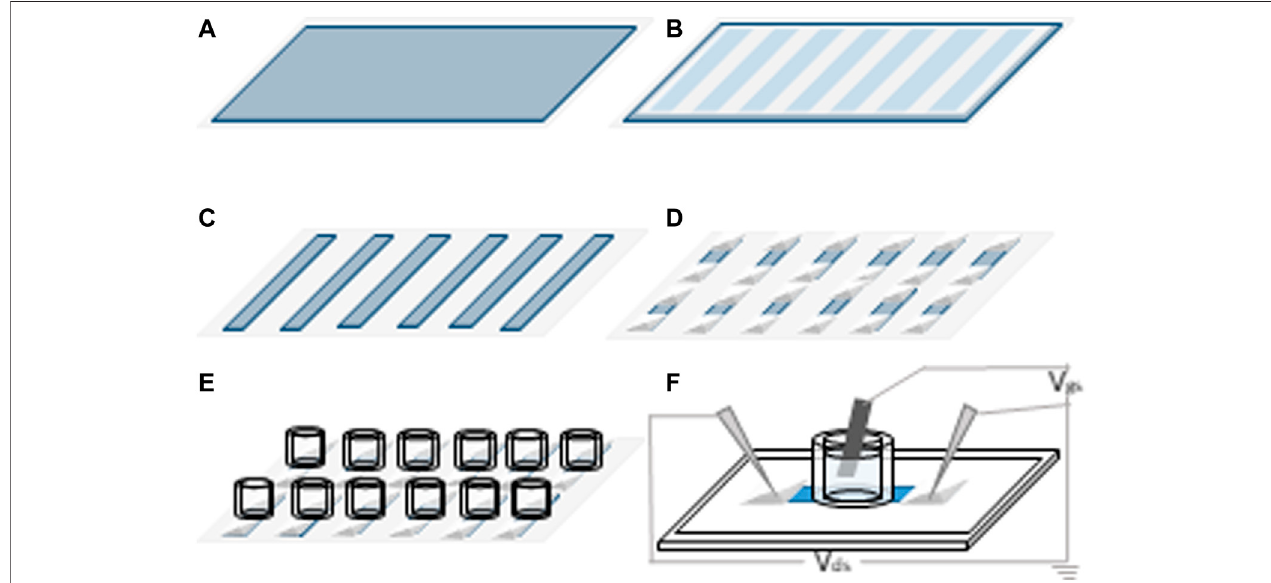
FIGURE1| SchematicrepresentationofthefabricationprocessofOECTs. (A) PEDOT:Toseitherelectrospunorspincoated; (B) PETstencilmaskisusedtocover thesamplesandprotectunexposedareas; (C) plasmaetchingisusedtoremovetheunprotectedareas; (D) silversource-drainelectrodesareprintedatbothextremities ofthepatterns; (E) cloningcylinderareusedtocon fi netheelectrolyteatthecenterofthedevice; (F) activatedcarbongateelectrodeisinsertedintotheglasscylinderand tungsten probes are used to connect source and drain electrodes to the measuring unit.